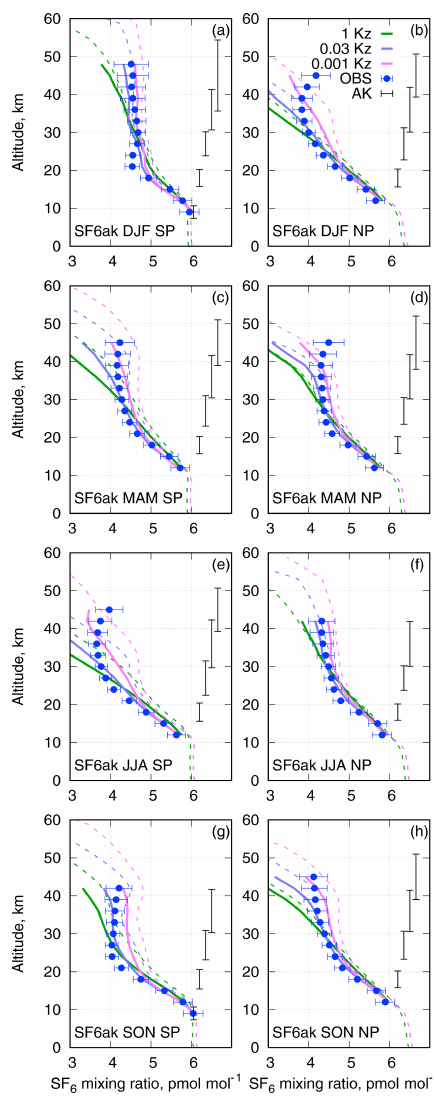
Figure 6. Seasonal mean co-located SILAM SF 6 and MIPAS pro- files for 2007, for southern and northern polar regions. Typical ranges covering 75% of the averaging kernel are given with the error bars at the right-hand side of each panel. The horizontal error bars indicate systematic uncertainties of the observations that are fully correlated among profiles and do not cancel out when averag- ing over a large number of measurements. Dashed lines are zonal- mean SILAM profiles for a given season taken without